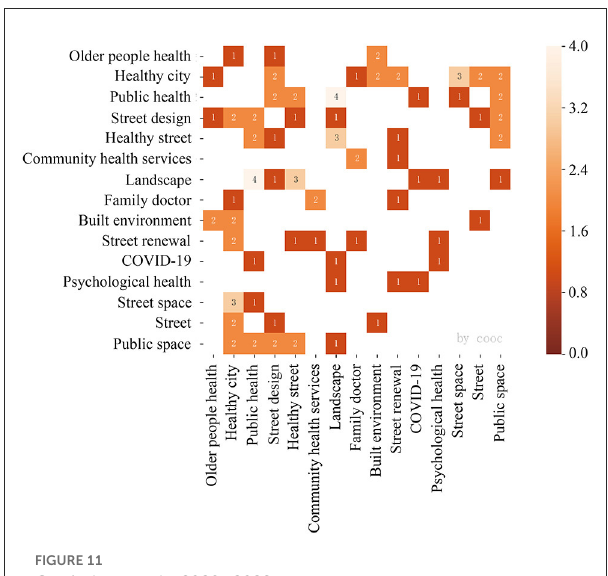
FIGURE11 Confusion matrix,